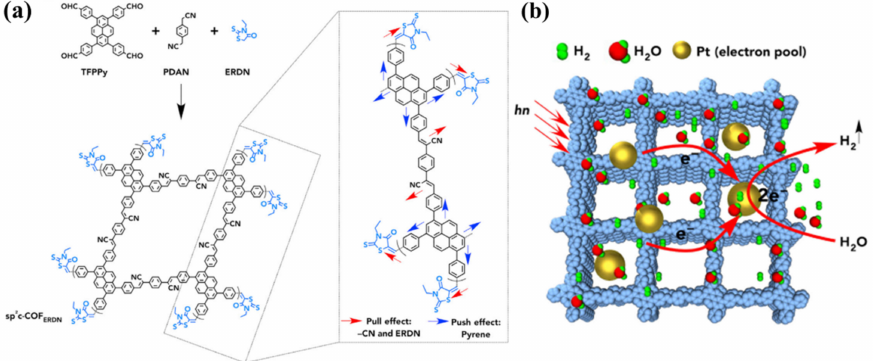
Figure 12. ( a ) Schematic representation of the synthesis of sp 2 c-COF ERDN and ( b ) PHP from water of sp 2 c-COF ERDN . Reproduced with permission from Ref. [56]. Copyright: Elsevier, 2019.